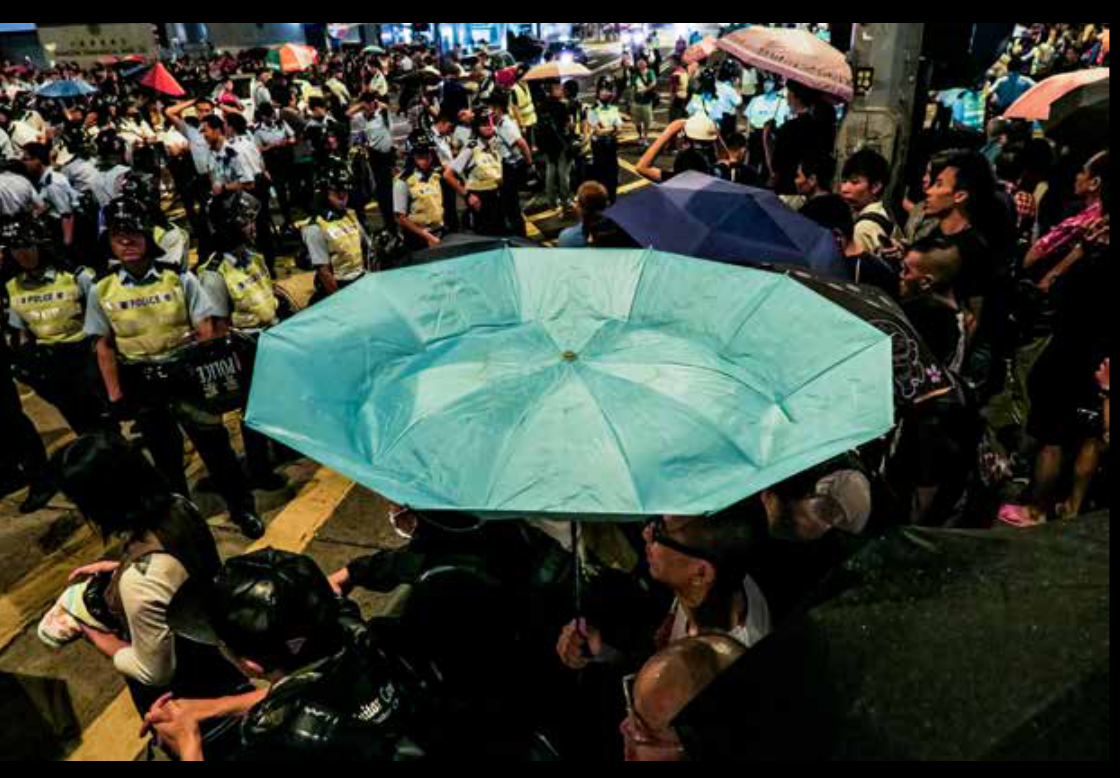
Figure 11b: Phil Shek, A Flipped Umbrella, Mong Kok, Kowloon,